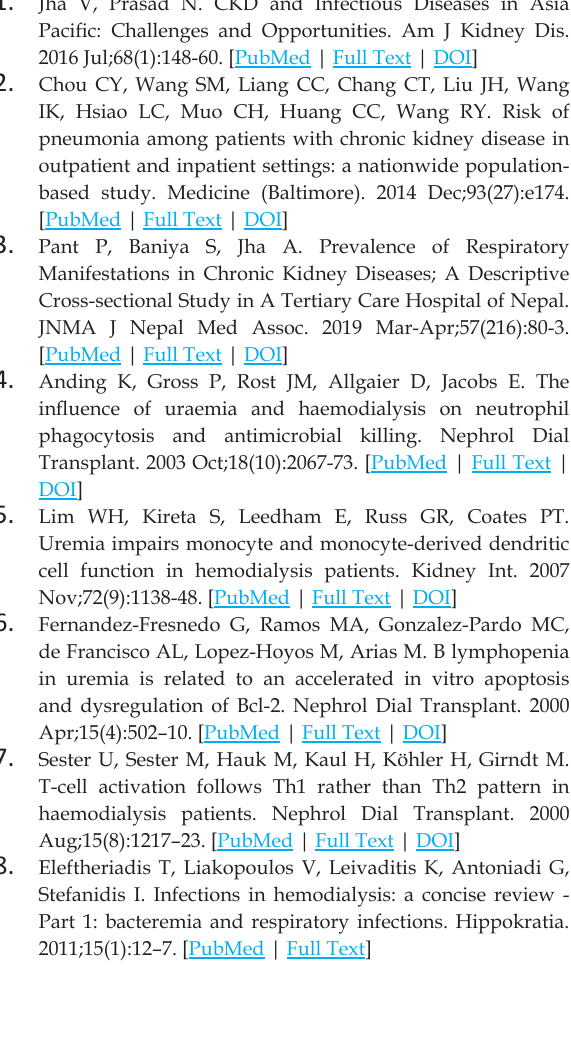
Free Full Text Articles are Available at